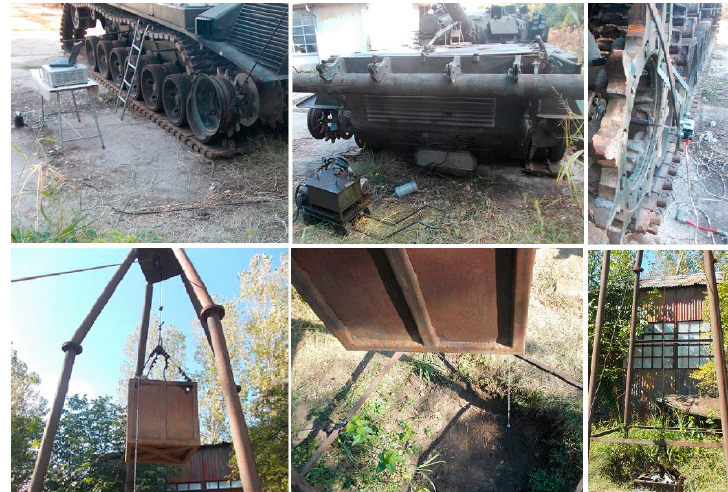
Figure 19. Testing using the computer-assisted gravitational method.